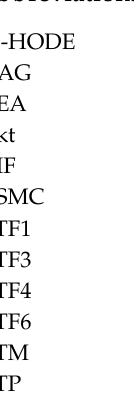
Table S1: Proliferative e ff ects of the exogenous TRPV1 agonists capsaicin and glycolic acid, the endogenous agonist AEA and its analogue, SKM-4-45-1, and the antagonists capsazepine and AMG9810; Table S2: [Ca 2 + ] i elevation induced by various endogenous and exogenous TRPV1 agonists and activators; Table S3: E ff ects of the TRPV1 agonist capsaicin on the Fas / CD95 cytosolic pathway; Table S4: Mitochondrial pathway e ff ects induced by TRPV1 agonists; Table S5: ER e ff ects induced by endogenous and exogenous TRPV1 agonists; Table S6: Nuclear e ff ects of endogenous and exogenous TRPV1 agonists; Table S7: E ff ects of exogenous and endogenous TRPV1 agonists on caspase activity; Table S8: Downstream pro-apoptotic e ff ects of endogenous and exogenous TRPV1 agonists and antagonists; Table S9: E ff ects of TRPV1 antagonists on transmembrane Ca 2 + transport; Table S10: E ff ects of TRPV1 antagonists on mitochondrial dysfunction; Table S11: E ff ects of TRPV1 antagonists on ER stress; Table S12: E ff ects of TRPV1 antagonists on nuclear activity; Table S13: E ff ects of TRPV1 antagonists on caspase activity; Table S14: E ff ects of TRPV1 antagonists on agonist-induced apoptosis; Figure S1: Activation of TRPV1 modulates pro- and anti-inflammatory signaling